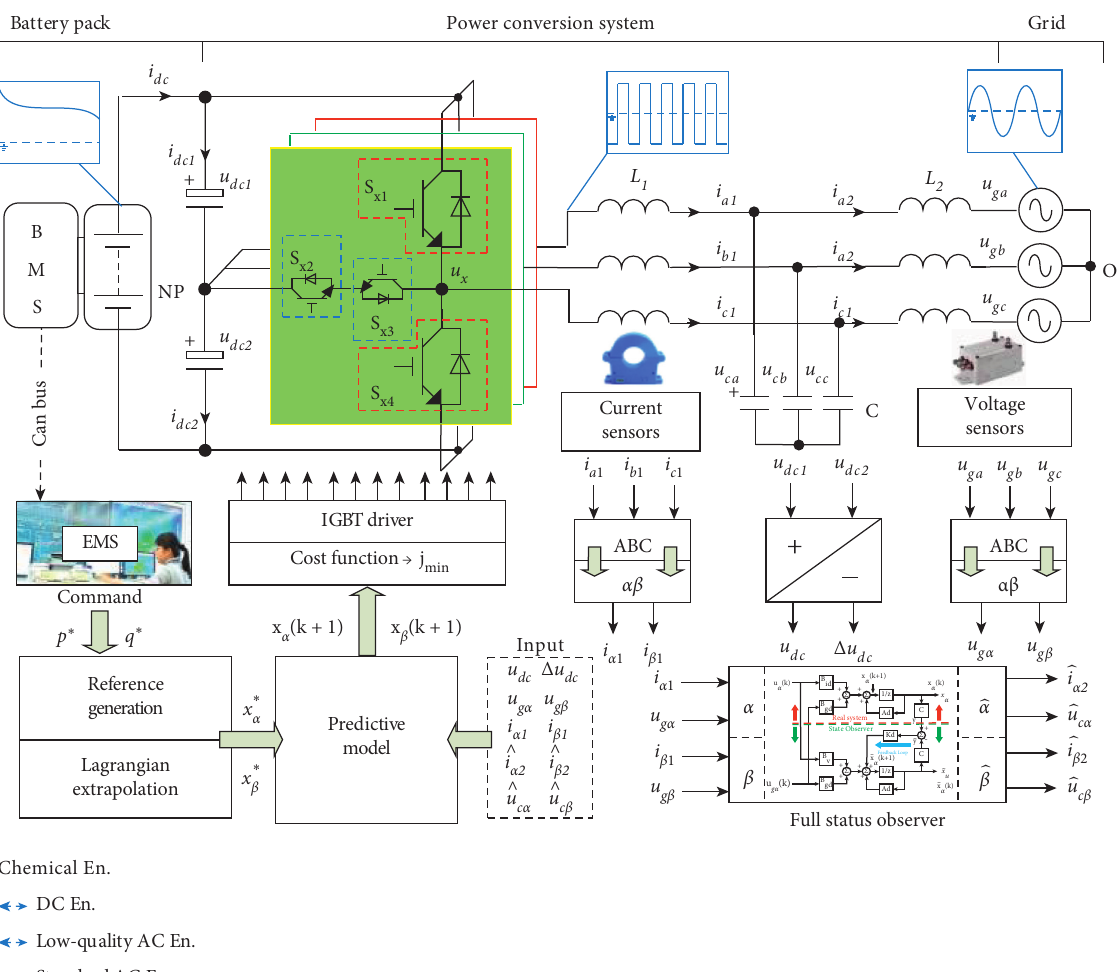
Figure 1: Structure of T-type three-level power conversion system for battery energy storage